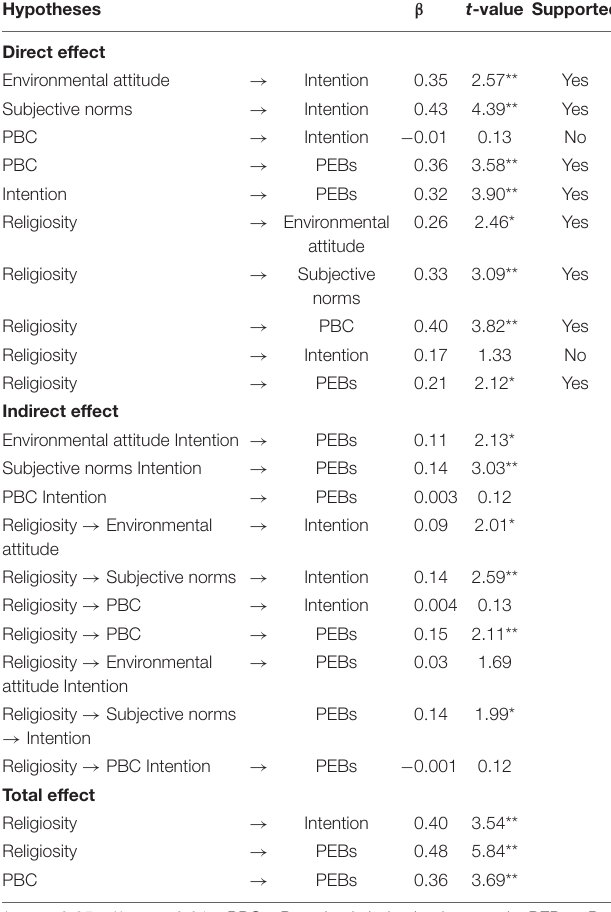
TABLE 5 | Direct, indirect, and total effects for the